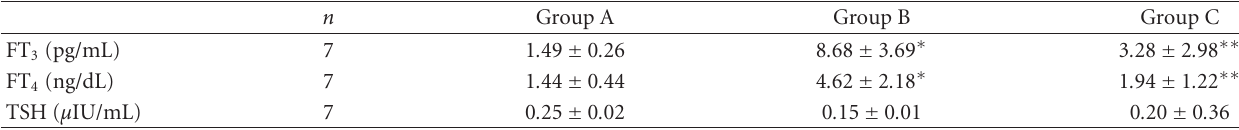
Table 1: Comparison of thyroid function tests.